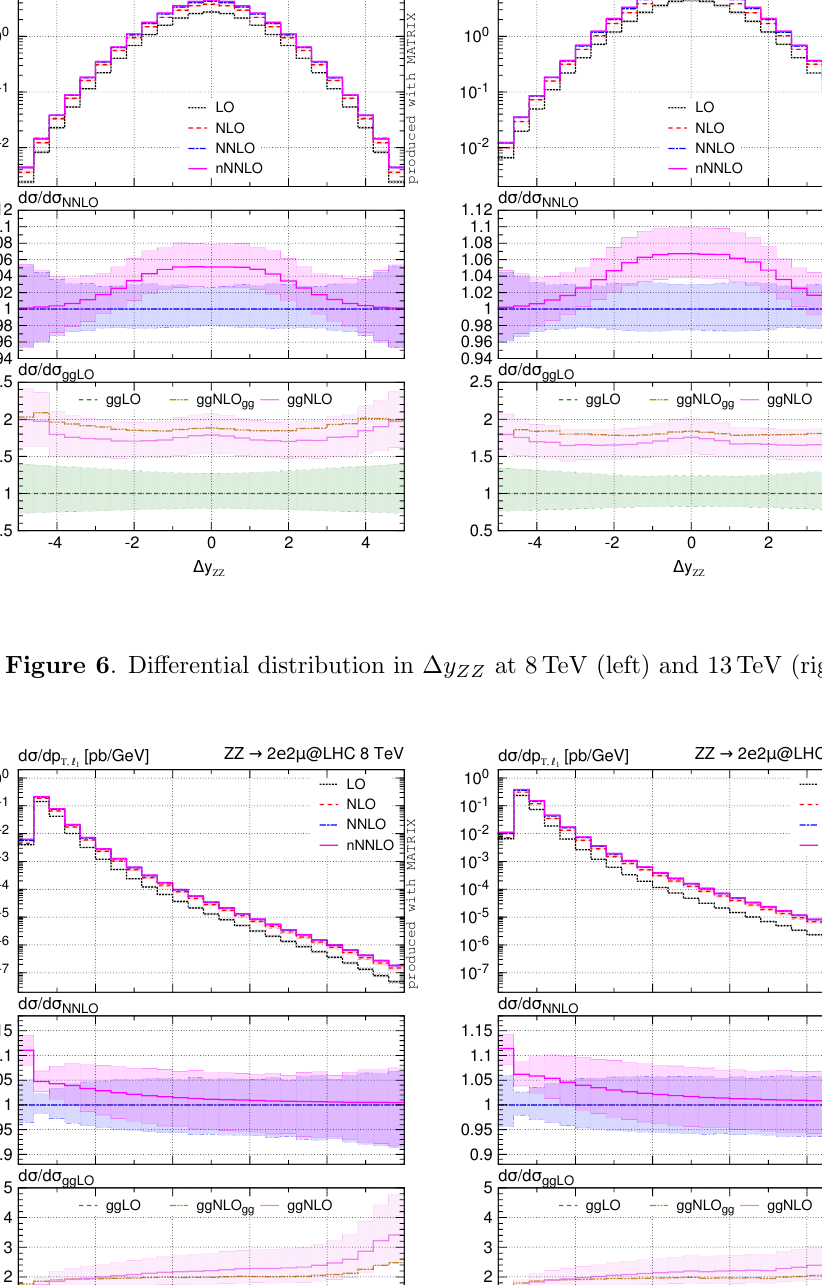
at 8 TeV (left) and 13 TeV 1